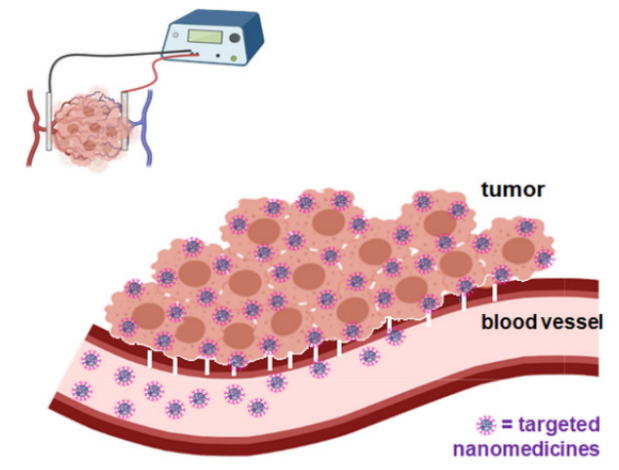
Figure 6. Targeted (functional ligand) nanomedicine and the EPR-enhanced effect by the application of electroporation.